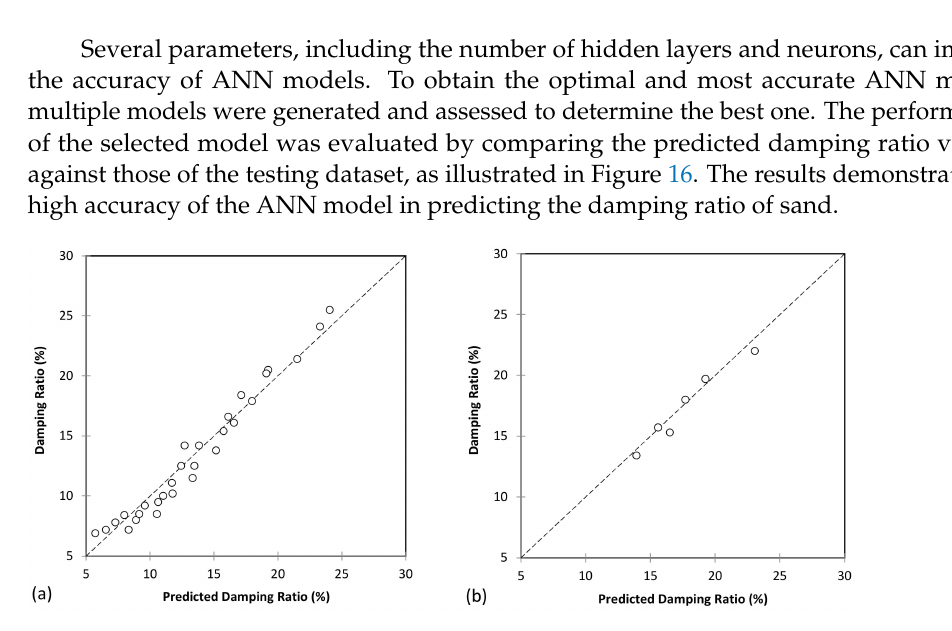
Figure 16. Performance of the best ANN model to predict the damping ratio for ( a ) training and ( b ) testing